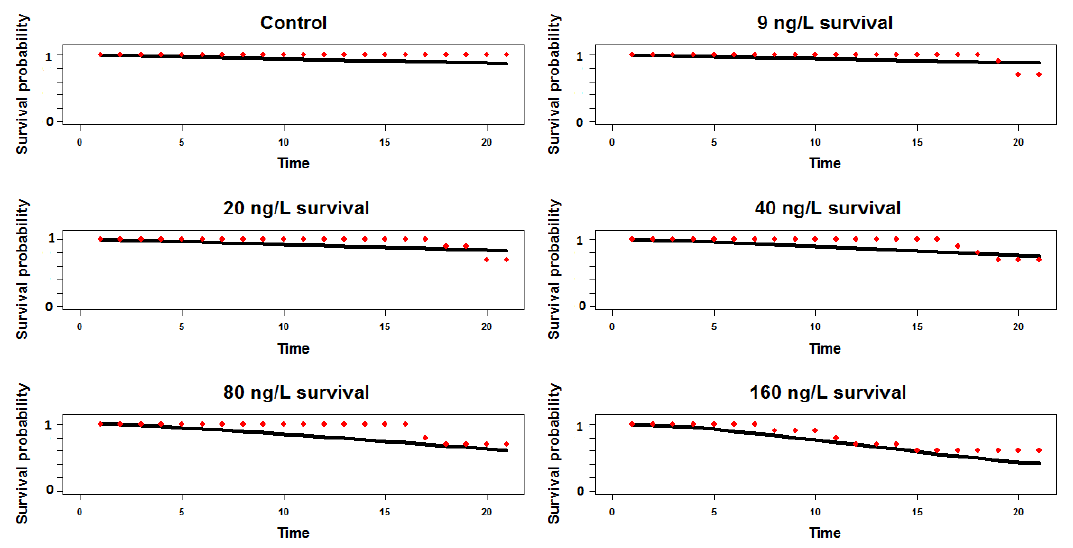
Fig. 3. Median survival fitting with 95% HDI where the black lines represent the solution trajectories of the survival dynamics and the red points reflect the experimental